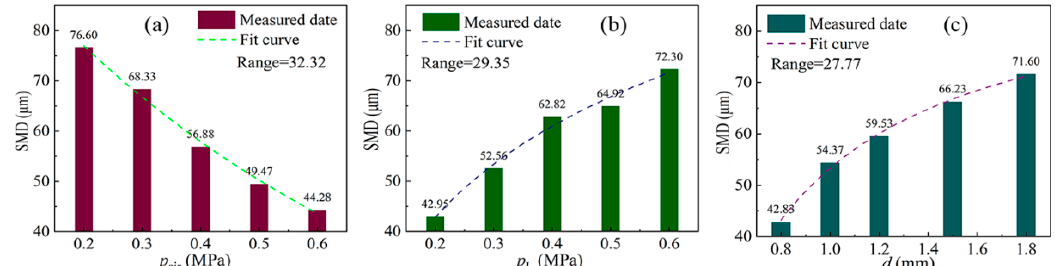
Figure 4. The relationship between SMD and three factors: ( a ) p air ; ( b ) p L ; and ( c ) d .